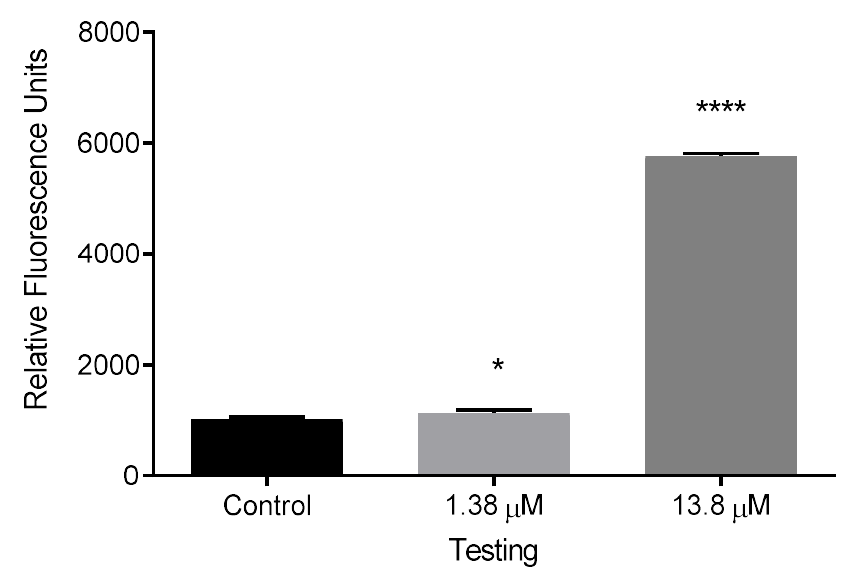
Figure 1. The graph represents the fluorescence data from biological testing after 10 min of incubation at 37 °C, one-way ANOVA data and Dunnett’s multiple comparison test results. Both these tests were run on Graphpad 6; the Dunnett’s multiple comparison data are represented using asterisks. (*): control, 2:[E] = 1.38 µM and 13.8 µM, respectively, [S] was controlled in all wells. The full details of concentrations and volumes used given in the appendix; Table 1. The error bars represent the standard deviation of replicates ( n = 3).